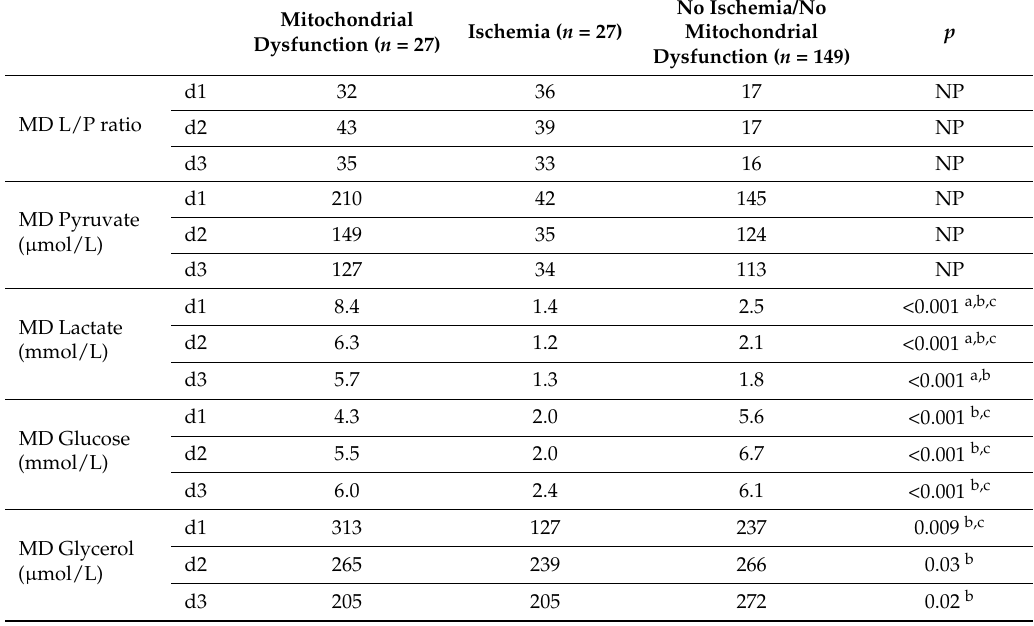
Table 2. Microdialysis (MD)-derived metabolites (median values) in the three groups defined as mitochondrial dysfunction, ischemia, and no ischemia/no mitochondrial dysfunction on days (d)